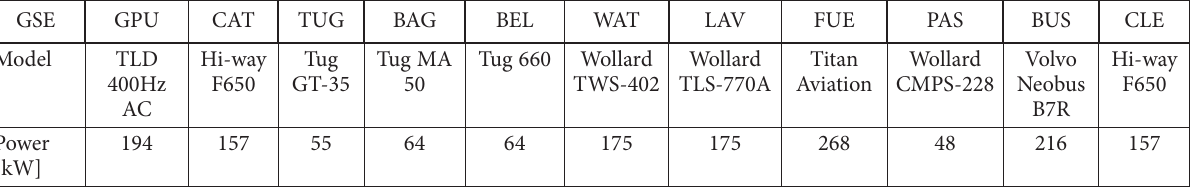
Table 11. Calculated loading factor per circulation for GSEs performing movements (source: authors) GSE CAT LAV WAT BAG